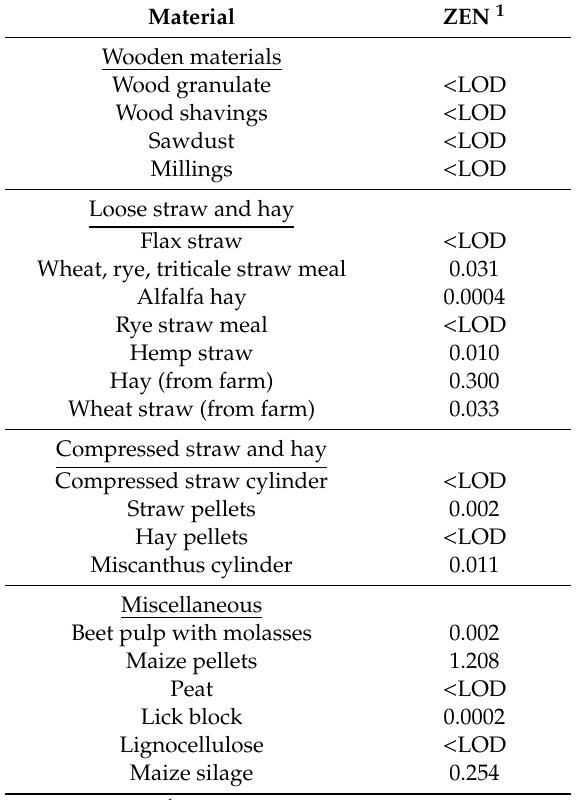
Table 5. Concentration of zearalenone (ZEN) in the tested organic materials in mg mycotoxin / kg material, based on a dry matter content of